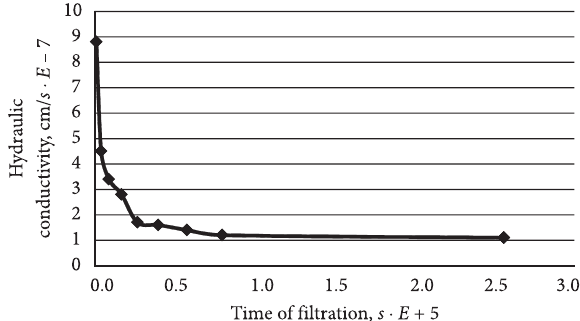
Fig. 5. Variations of clay hydraulic conductivity in time when the filtering and the thawing takes place at the same time in filtering chamber